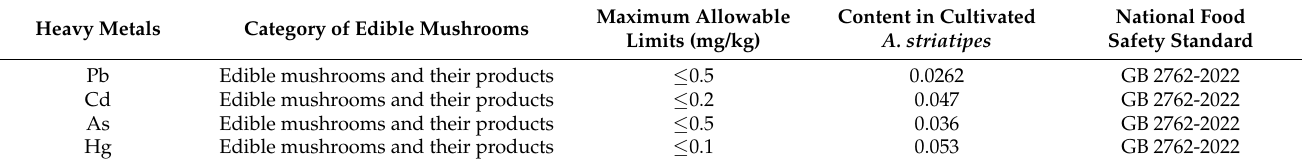
Table 4. The maximum allowable limits of heavy metals in edible mushrooms.